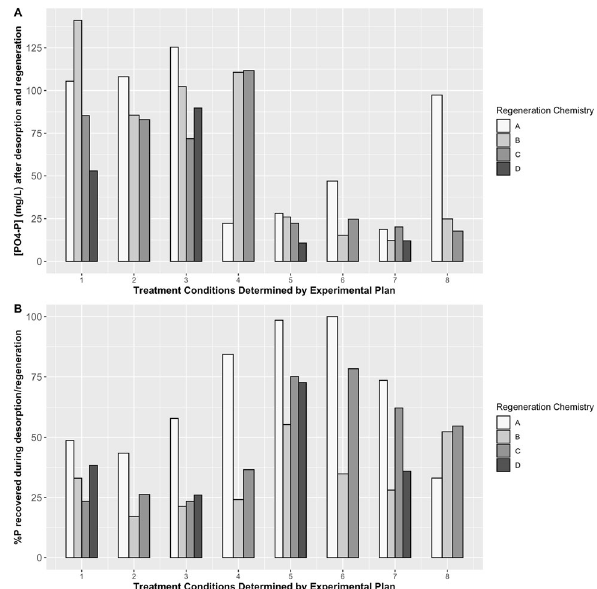
Fig. 2 Graphical representation of the ef fl uent P concentrations and recovery ef fi ciencies with respect to the experimental set and conditions for each experiment (Tables 1 – 3). a Desorption ef fl uent concentration (mg PO 4 -P/L) vs. regenerant solution and operational conditions; b P recovery ef fi ciency (%) vs. regenerant solution and operational